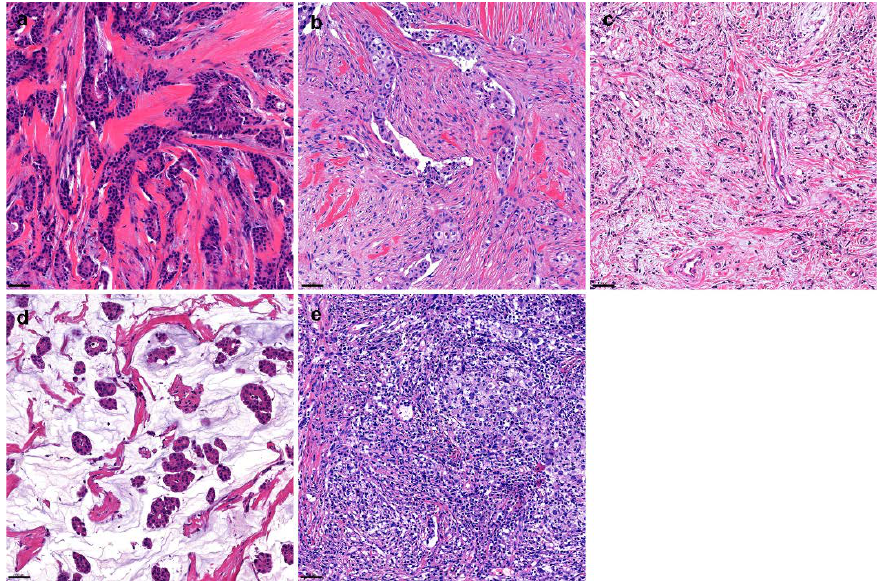
Figure 2. Variable tumor stroma types of breast cancer. The tumor stroma can be variably present. In this study, the stroma was divided into collagenous ( a ) and non-collagenous ( b – e ) types. The col- lagenous stroma is characterized by dense, pinkish, cellular collagenous fibrosis ( a ). Non-collagenous stroma includes stroma with mesenchymal cellular components ( b ), loose and sparse cellular compo- nents ( c ), mucinous components ( d ), or inflammatory components ( e